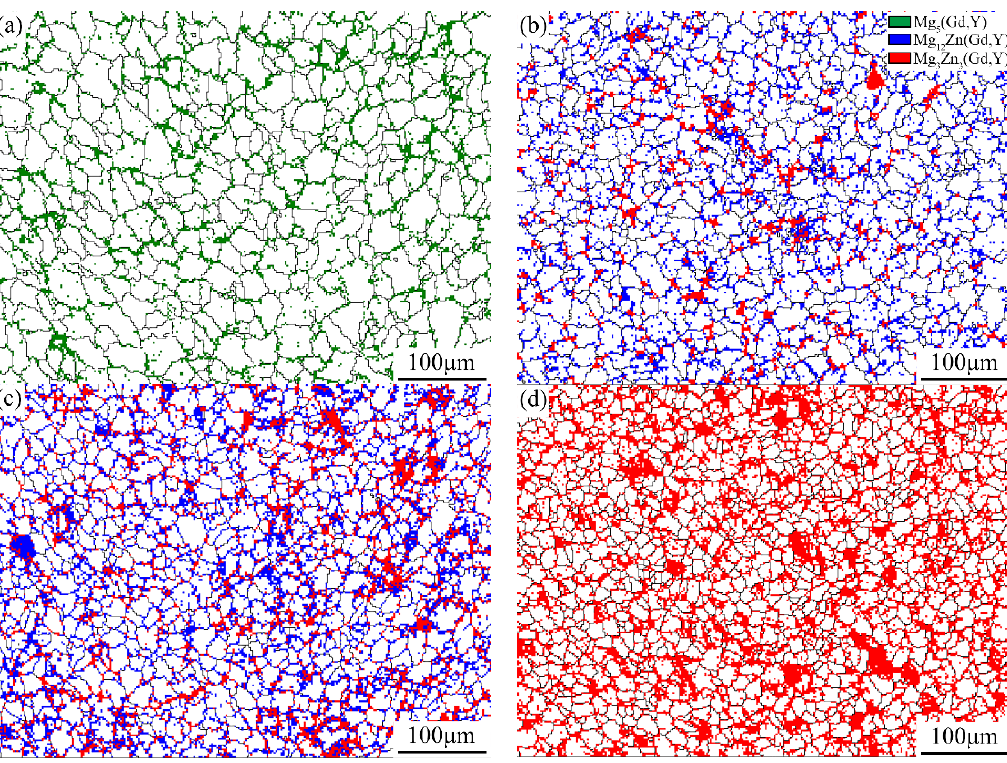
Figure 12. Grain morphology of Mg–7Gd–5Y– x Zn–0.5Zr alloy displayed by EBSD images: ( a ) x = 0 wt%; ( b ) x = 3 wt%; ( c ) x = 5 wt%; ( d ) x = 7 wt%.